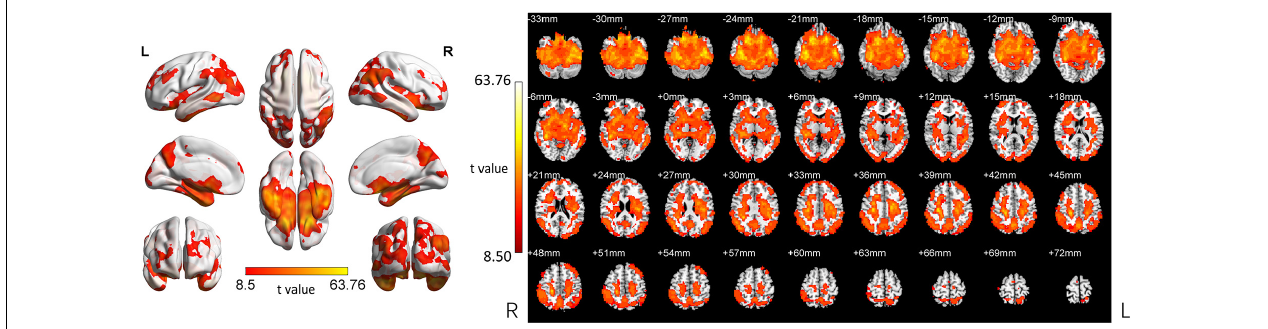
FIGURE 1 | ANOVA revealed differences among the three groups. ReHo was significantly different among the three groups (Two-tailed ANOVA-test; FDR p < 0.001, k > 10 voxels). ANOVA, one way analysis of variance. The color bars indicate t -values, blue color represents negative values and red color represents positive values. L, Left; R,